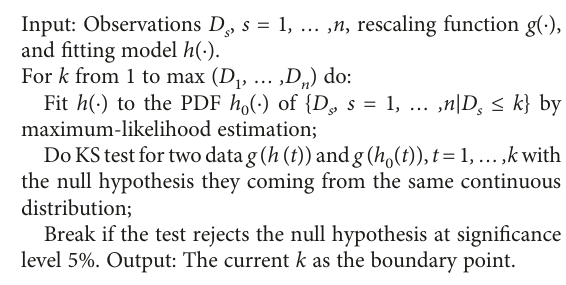
Algorithm 1: A boundary detection algorithm for probability density